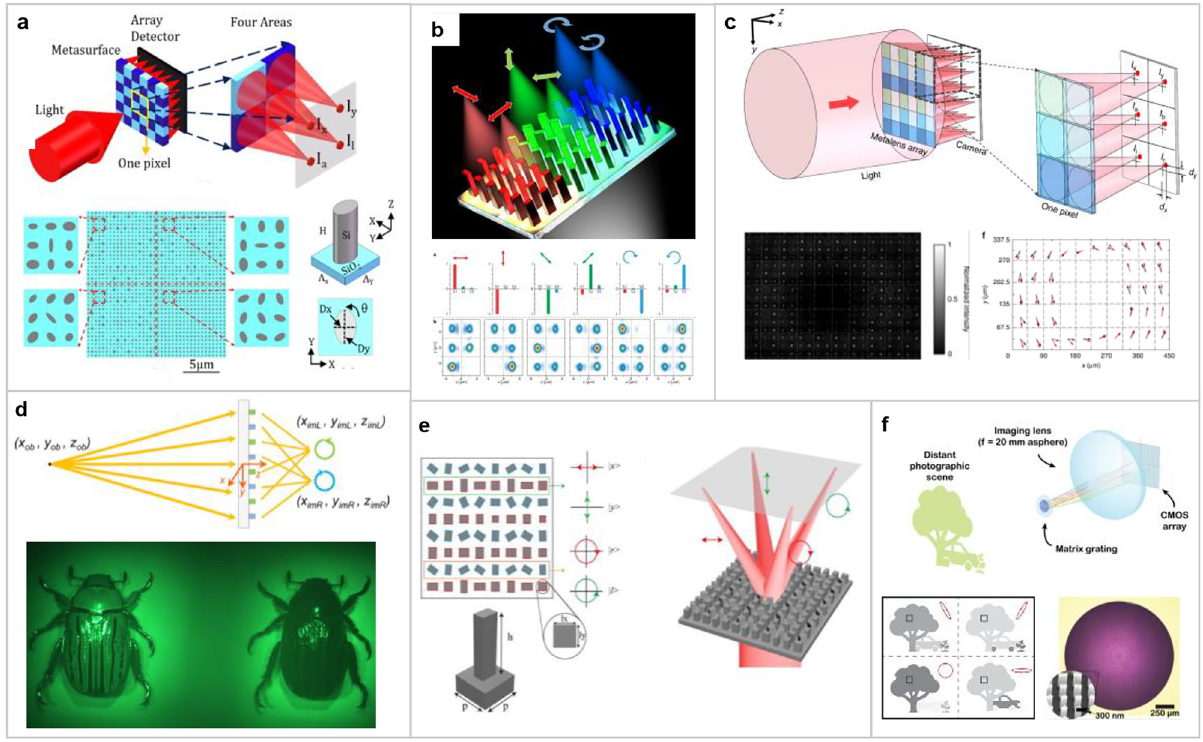
Figure 9: Applications of polarization detection with all-dielectric metasurfaces. (a) A Si metasurface-based polarimeter array for Stoke parametersdetectionbymeasuring x -, y -,45 ° linearpolarizedlightandleftcircularpolarizedlight[128].(b)ASimetasurfacedividinglightinto sixbasicpolarizationcomponentsforStokeparametersmeasurement[130]. (c) A Simetasurface-basedgeneralizedHartmann – Shacksensor for stateof polarization andphase pro fi lemeasurement [131]. (d)A TiO 2 metasurface formingtwo imagesof anobject inthe same fi eld of view and opposite charity [133]. (e) A TiO 2 metasurface focusing four kinds of polarizations to four spots for both linear polarization imaging and chiral imaging [134]. (f) A metasurface-based grating for full-Stokes polarization analysis [135]. Reprint permission obtained from [128, 130, 131, 133 –